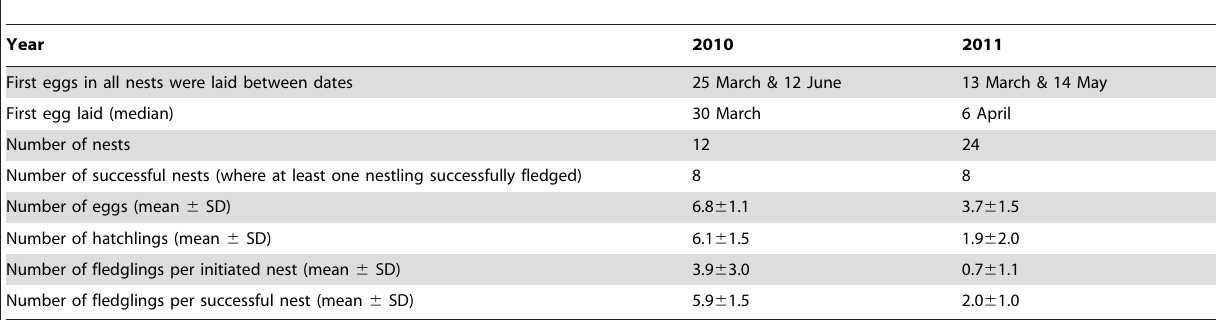
Table 1. Results of breeding data of the studied population.